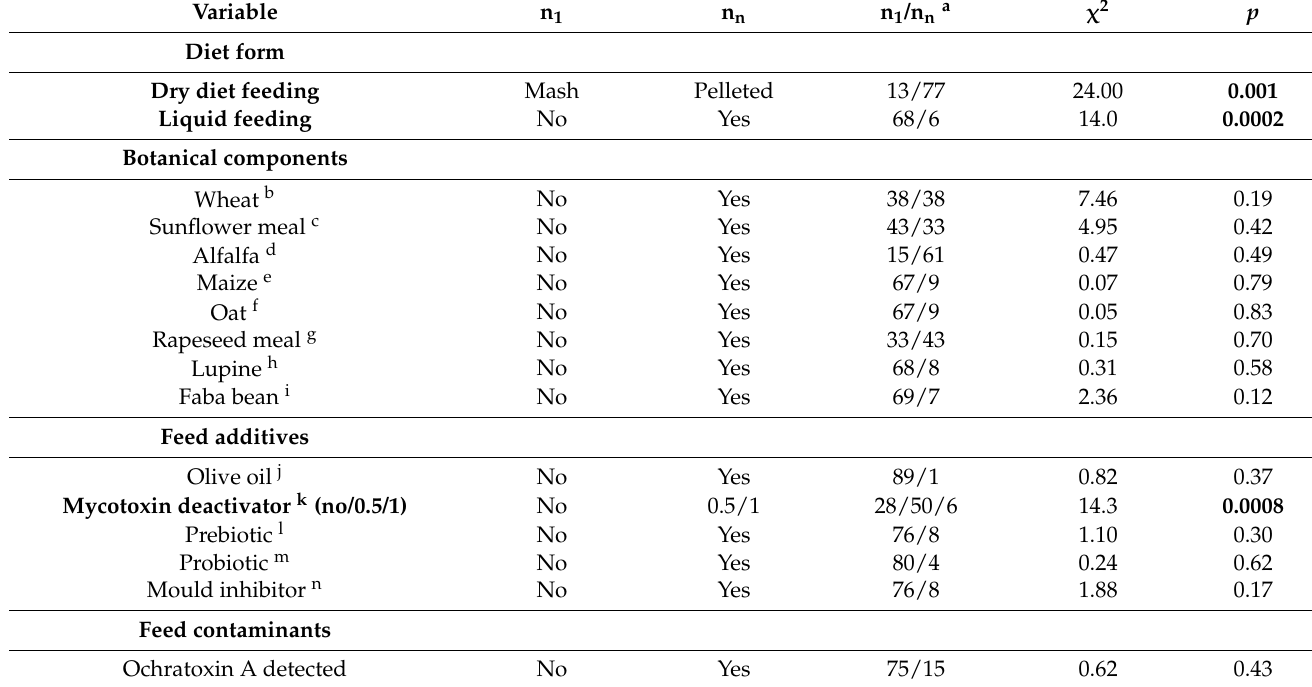
Table 3. Descriptive statistics of the nominal predictor variables and their association to the gastric ulcers prevalence in pig